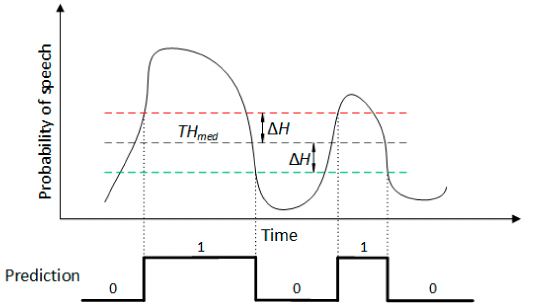
Figure 2. Hysteretic thresholding. For a window to be considered positive after the previous ones had been negative , the probability must be greater than TH med + ∆ H . Similarly, for the opposite case, the threshold is TH med − ∆ H